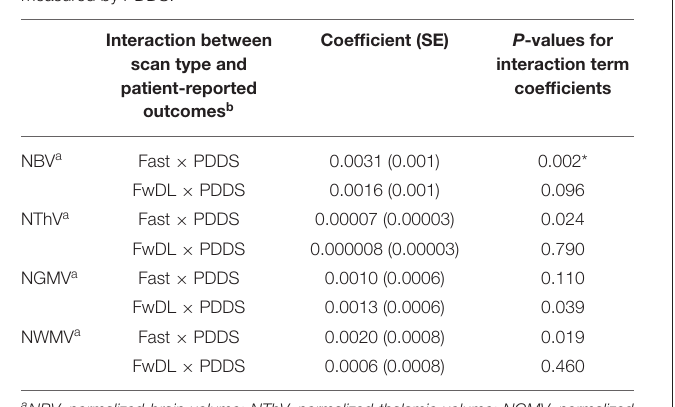
TABLE 3 | Linear mixed-effects model with conventional MRI scans as baseline and interaction with gait and physical impairment in multiple sclerosis as measured by PDDS.